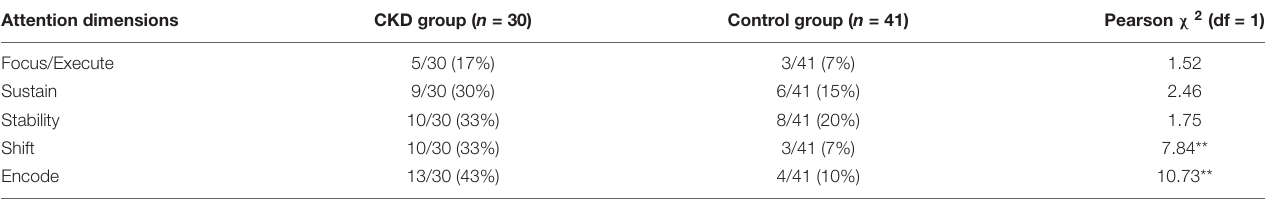
Attention dimensions